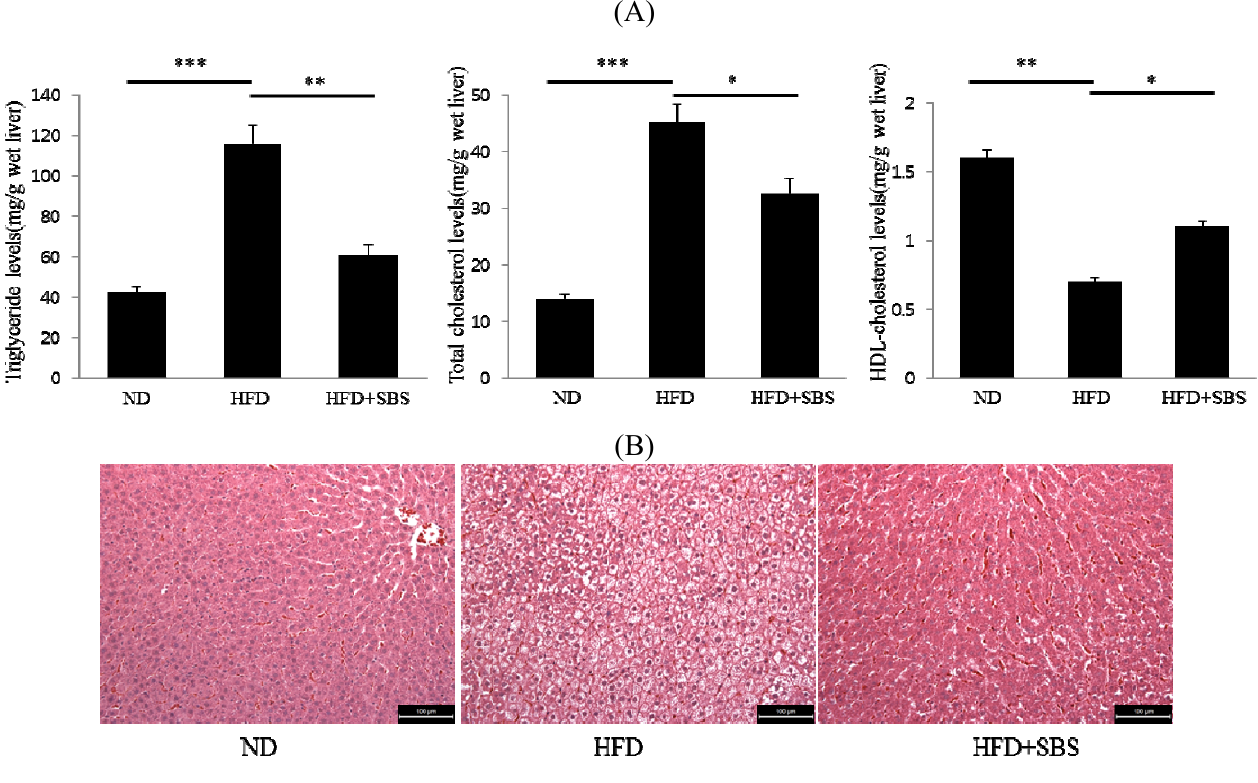
Figure 2. SBS reduces hepatic lipid levels in HFD-induced hepatic steatosis in